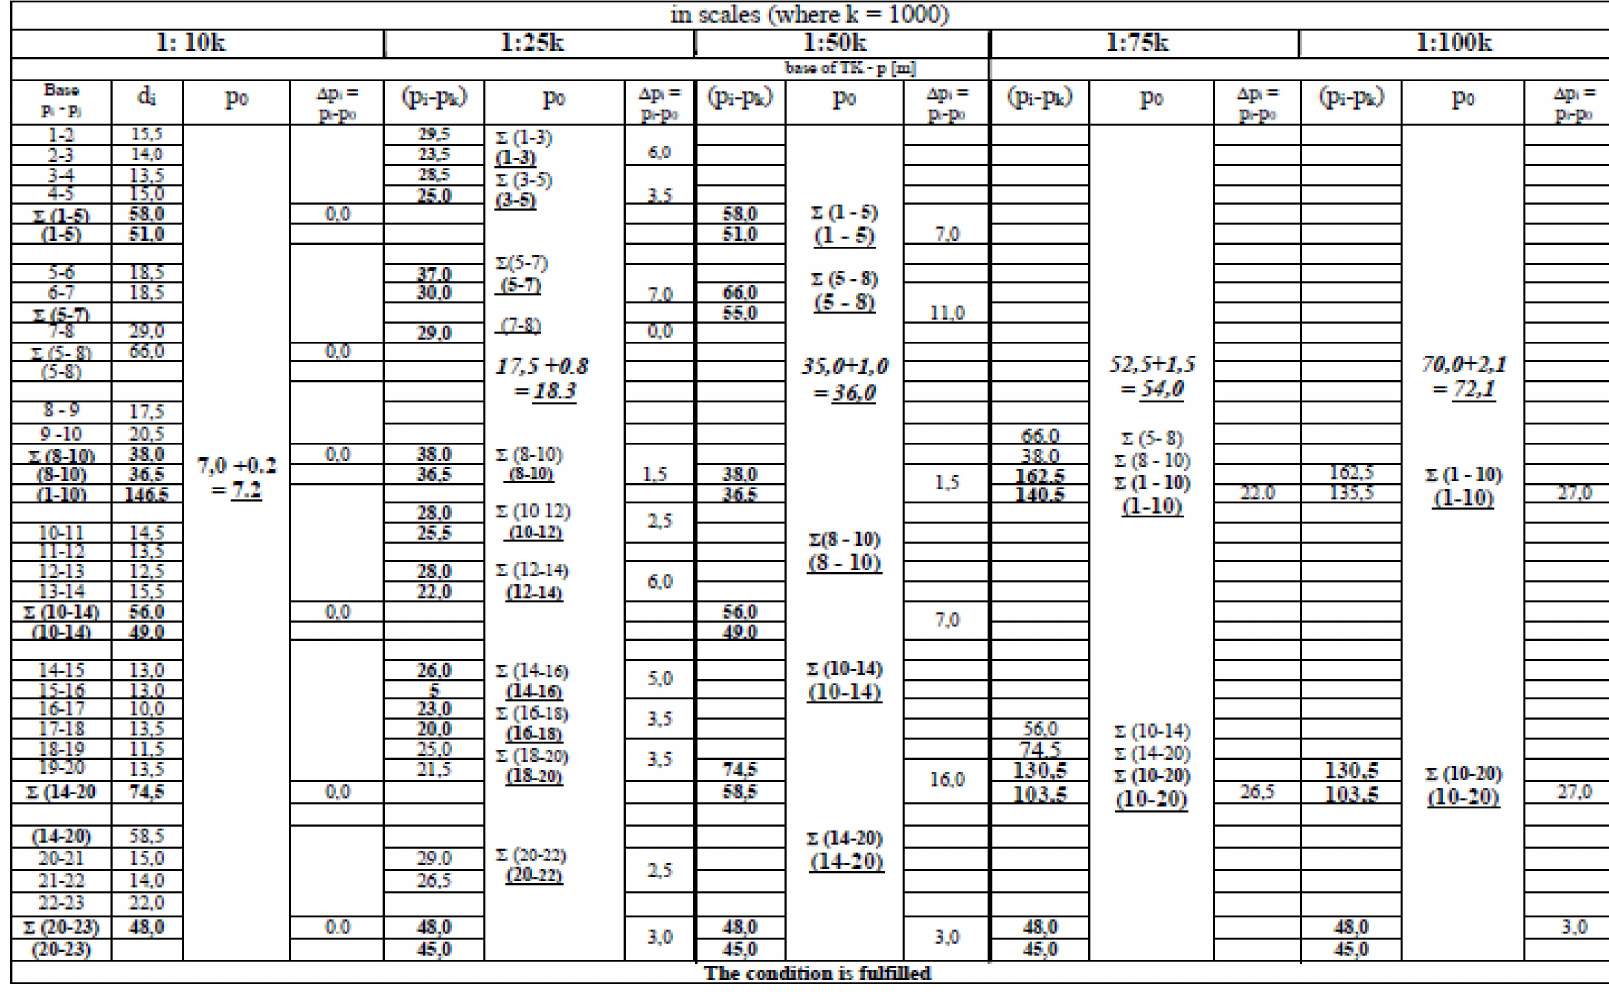
Figure A9. Verification of scale-dependent contractive mappings of polyline (broken line) into TK triangles of bases pi , according to the Cauchy condition and minimum dimensions of